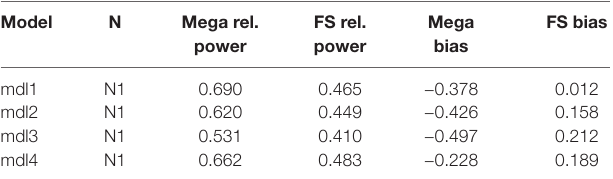
TABle 4 | Results for sample size condition 1 when no reference panel data were included. Model n Mega rel.